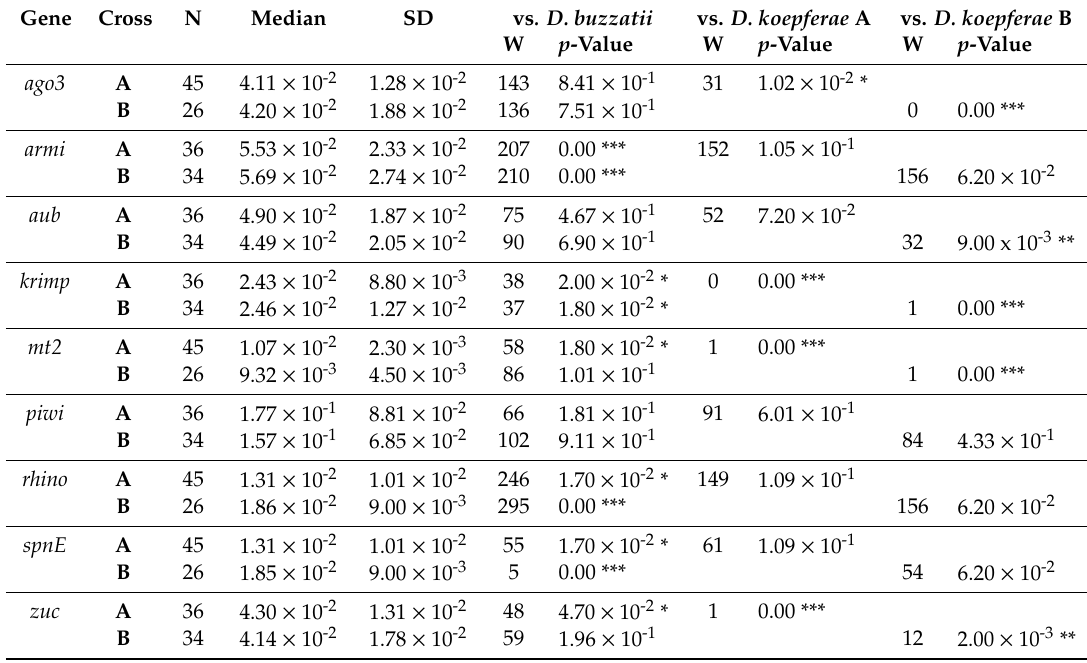
Table 4. Comparison of the di ff erent gene expression levels between hybrids and parental species ( D. koepferae and D. buzzatii